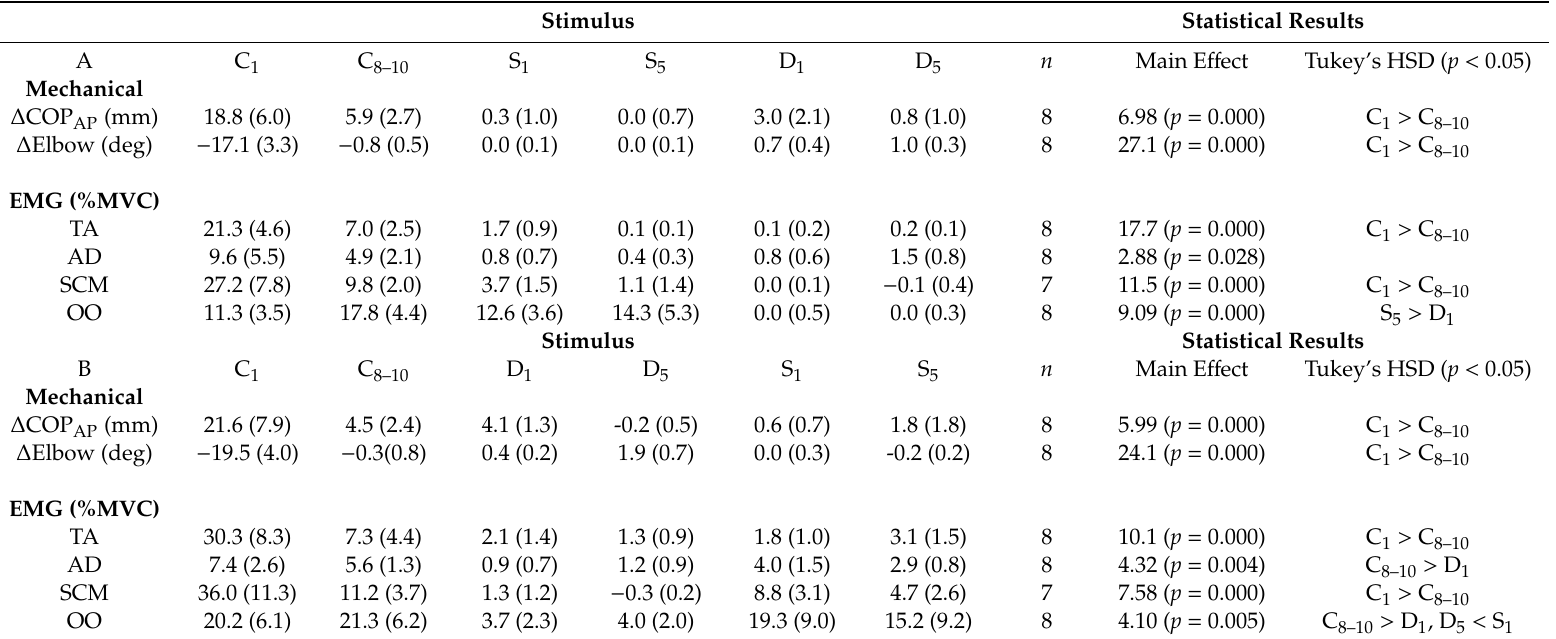
Table 2. Change in COP AP position and elbow angle, and normalized muscle response